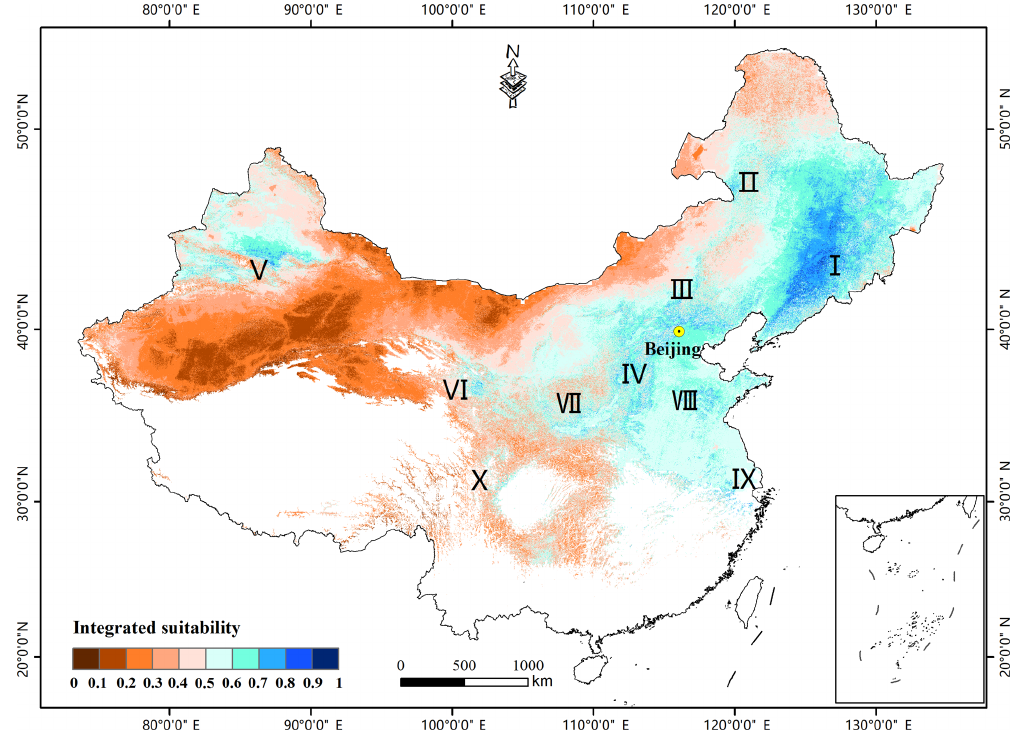
The Cryosphere, 13, 2149–2167, 2019